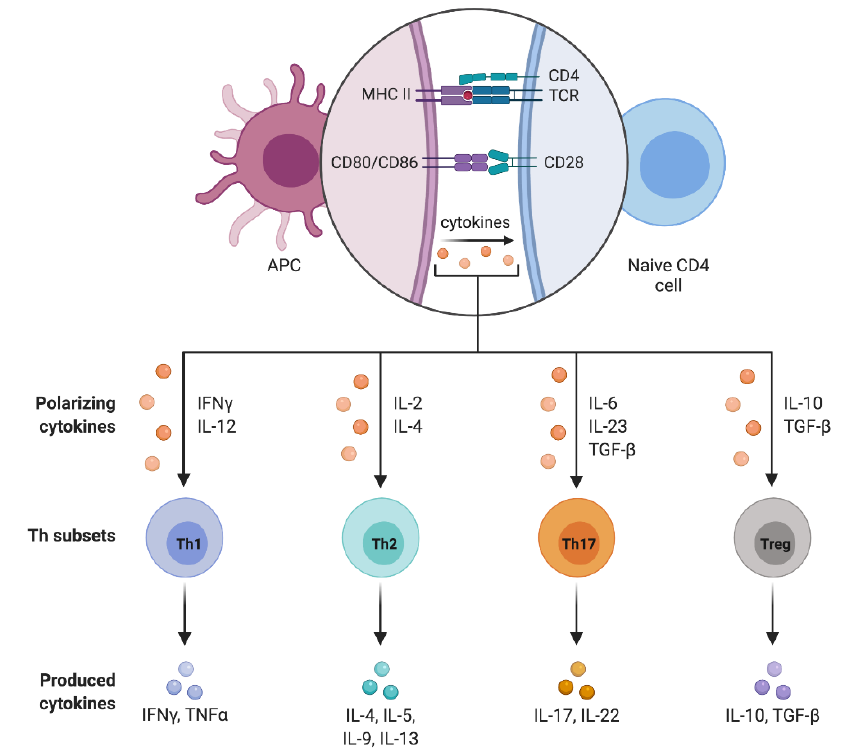
. Figure 2. CD4+ T cell